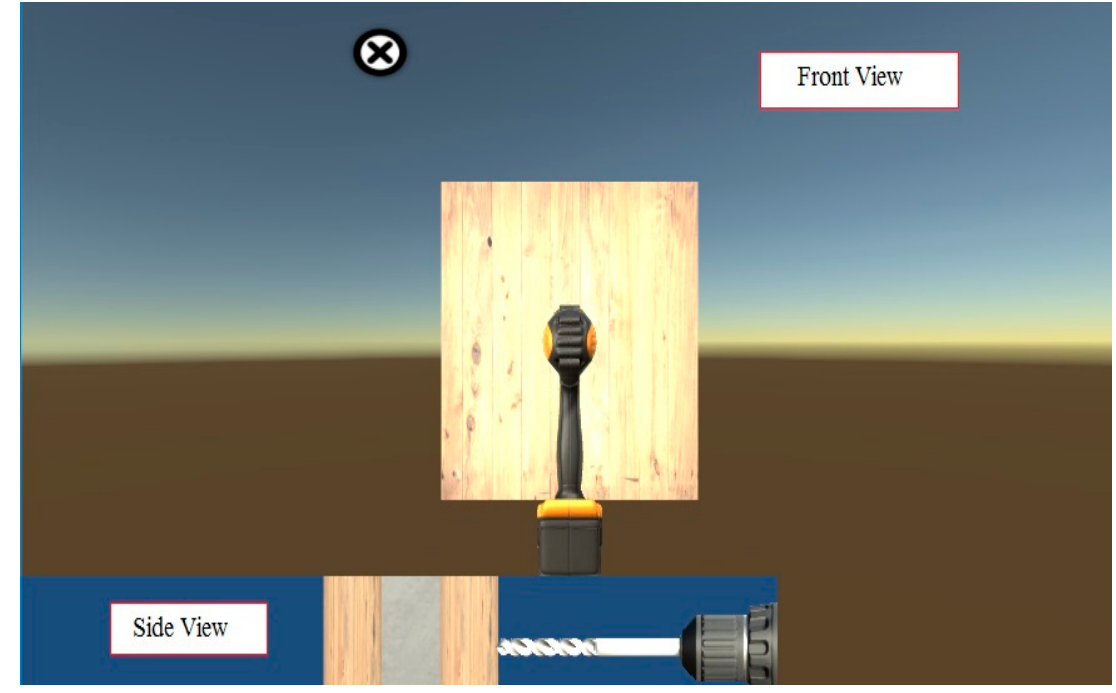
Figure 5. Participant practice session view.